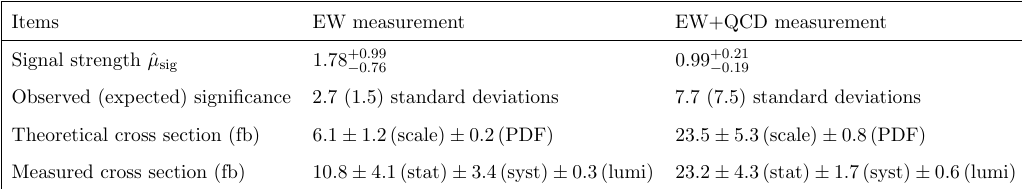
Table 3 . Summary of the measured and predicted